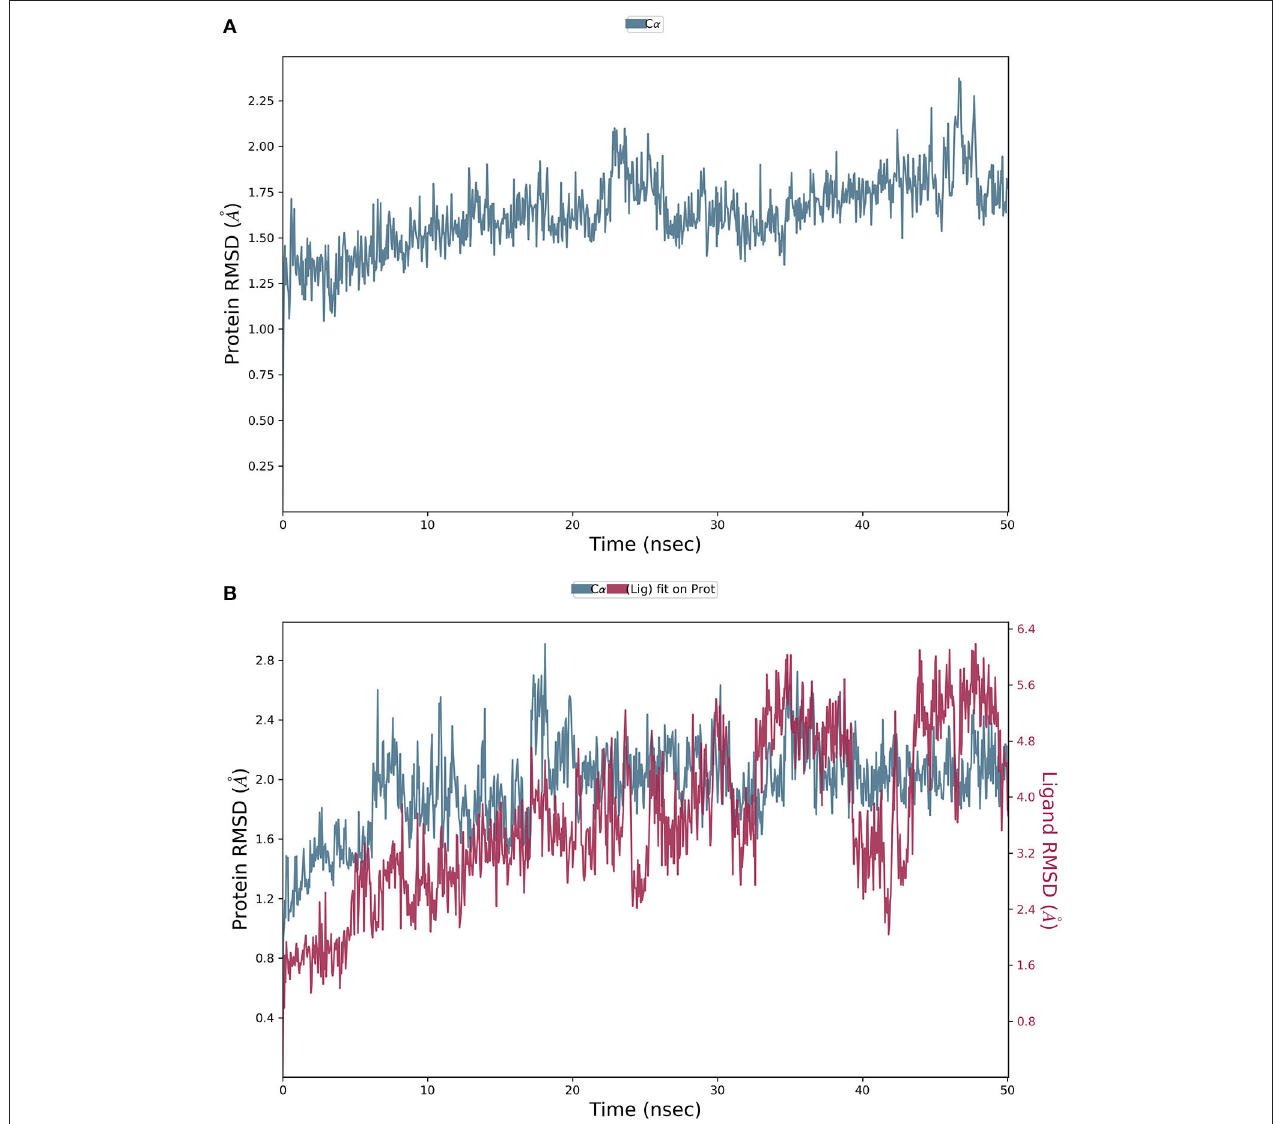
FIGURE 8 | Results of MD of DMO-SARS-CoV-2 M pro complex. (A) RMSD of the apo form of M pro . (B) RMSD of the DMO-M pro complex. RMSDs were stable, < 2.4 Å, and converged throughout the run time, indicating the complex’s stability.